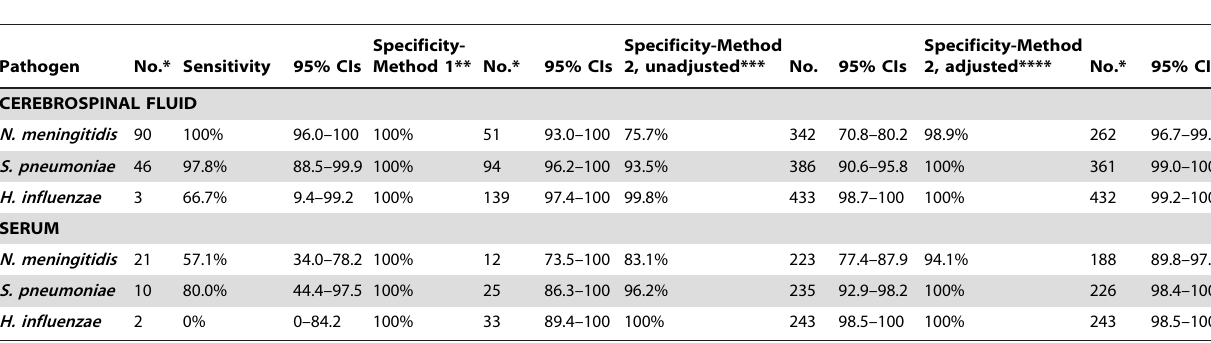
Table 2. Determination of sensitivity and specificity of RT-PCR assay for N. meningitidis ( ctrA ), S. pneumoniae ( lytA ), and H. influenzae ( bexA ) in cerebrospinal fluid and serum specimens (see text for details).